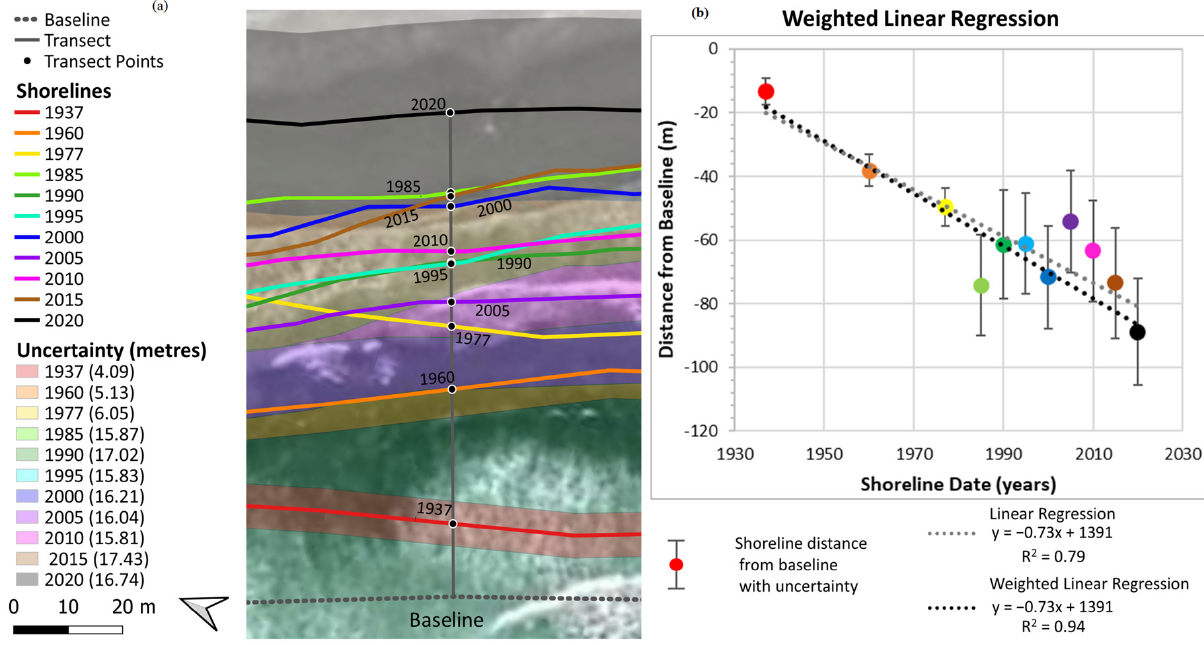
Figure 3. ( a ) Map of a perpendicular transect through the shoreline positions from the different time periods and their respective uncertainty values as buffers. ( b ) Plot of the linear regression and weighted linear regression for distance from the baseline versus time.